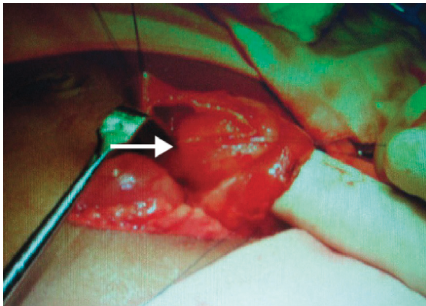
Figure 4: Obstruction at the 2nd part of the duodenum with windsock deformity (white